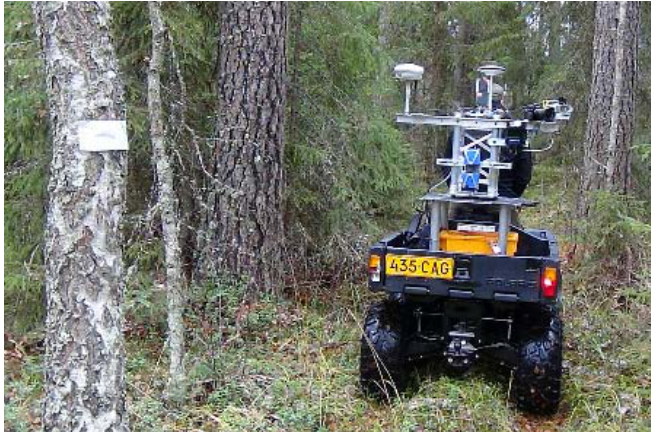
Figure 1. An ATV with global satellite navigation systems (GNSS) antennas and receivers, inertial measurement unit (IMU) and laser scanner equipment mounted on it for the purposes of the